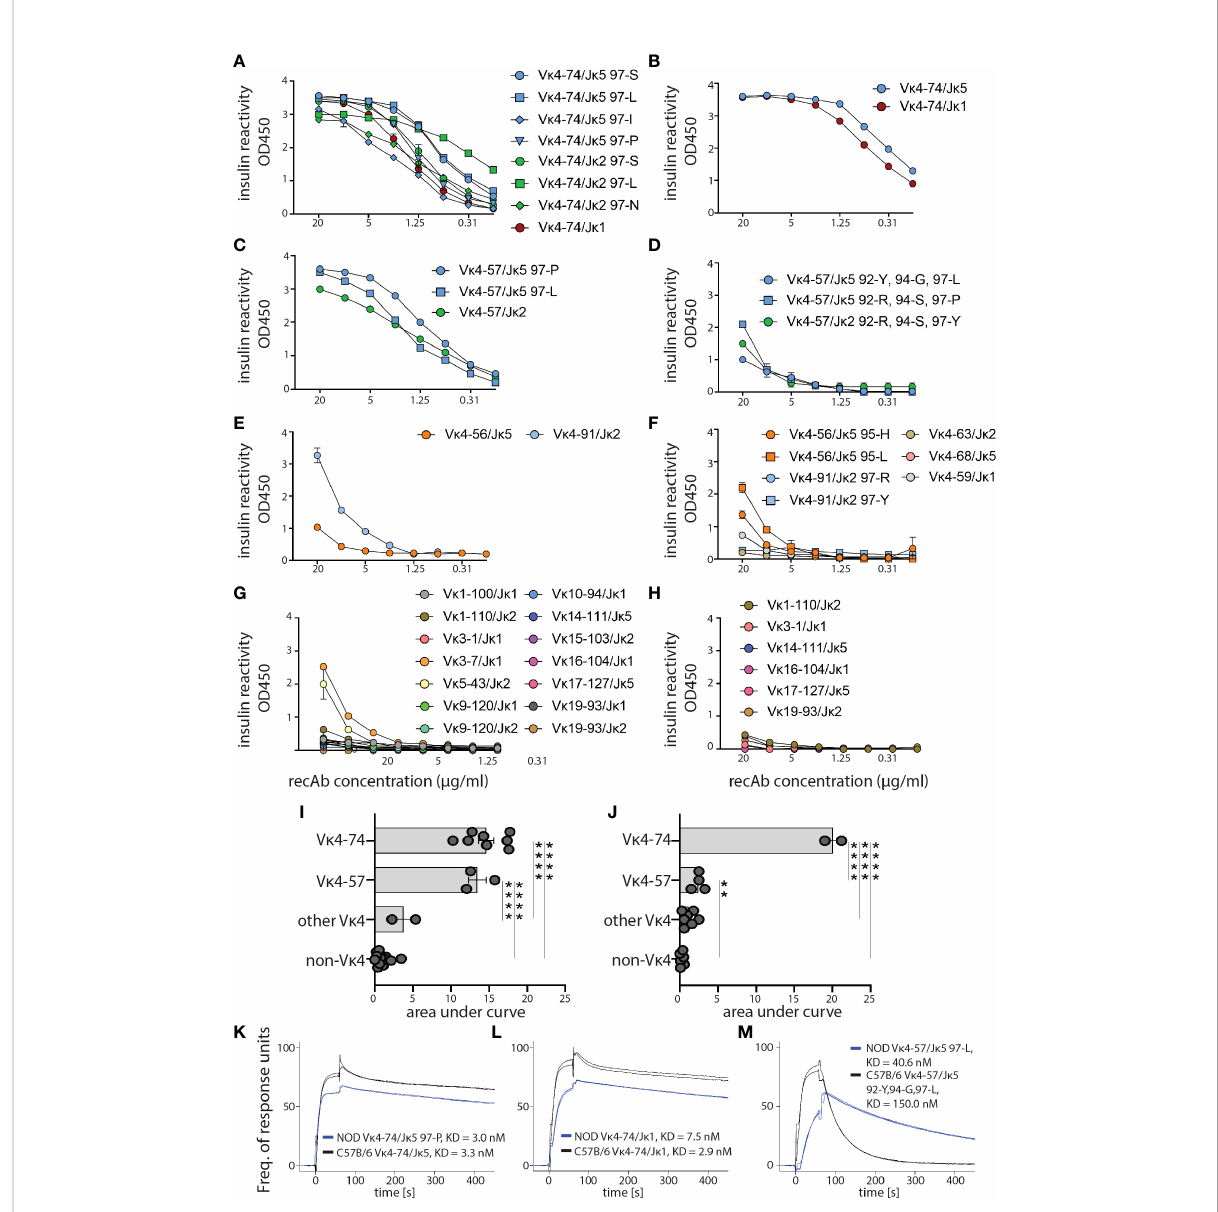
FIGURE 5 Af fi nity of anti-insulin binding antibodies from VH125.NOD and VH125.C57BL/6-H2g7 genetic backgrounds. Ig k chains from splenic high-af fi nity IBCs of VH125.NOD and VH125.C57BL/6-H2g7 by scRNA-seq and sequencing with degenerate primers, respectively, were selected for recombinant antibody (recAb) expression. (A – H) ELISA with insulin coated plates for speci fi city measurements with recAbs containing VH125 heavy chain and light chains derived from splenic high-af fi nity IBCs of either VH125.NOD (A, C, E, G) or VH125.C57BL/6-H2g7 (B, D, F, H) . RecAbs were grouped into V k 4-74 (A, B) , V k 4-57 (C, D) , other V k 4 families (E, F) , and non-V k 4 (G, H) . (I, J) Area under ELISA curves for different groups of recAbs containing Ig k of VH125.NOD (I) and VH125.C57BL/6-H2g7 (J) . (K, L) SPR curves indicating af fi nity (KD) and kinetics of 0.8μM insulin binding by recAbs with V k 4-74 (K, L) and V k 4-57 (M) . Results are pooled from at least three independent experiments and represented as the mean ± SEM. One-way ANOVA, followed by post hoc Tukey ’ s multiple comparisons tests. **P < 0.005, ****P <